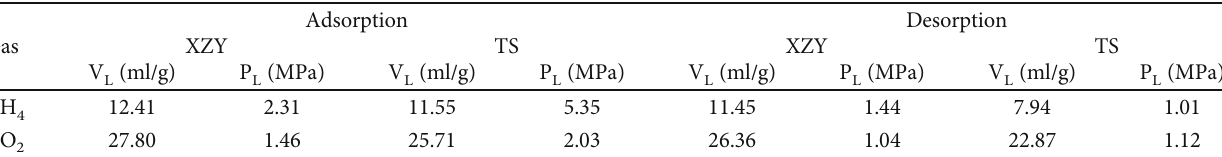
Figure 4: Experimental and Langmuir isotherms for adsorption and desorption of two coal samples. Table 1: Langmuir